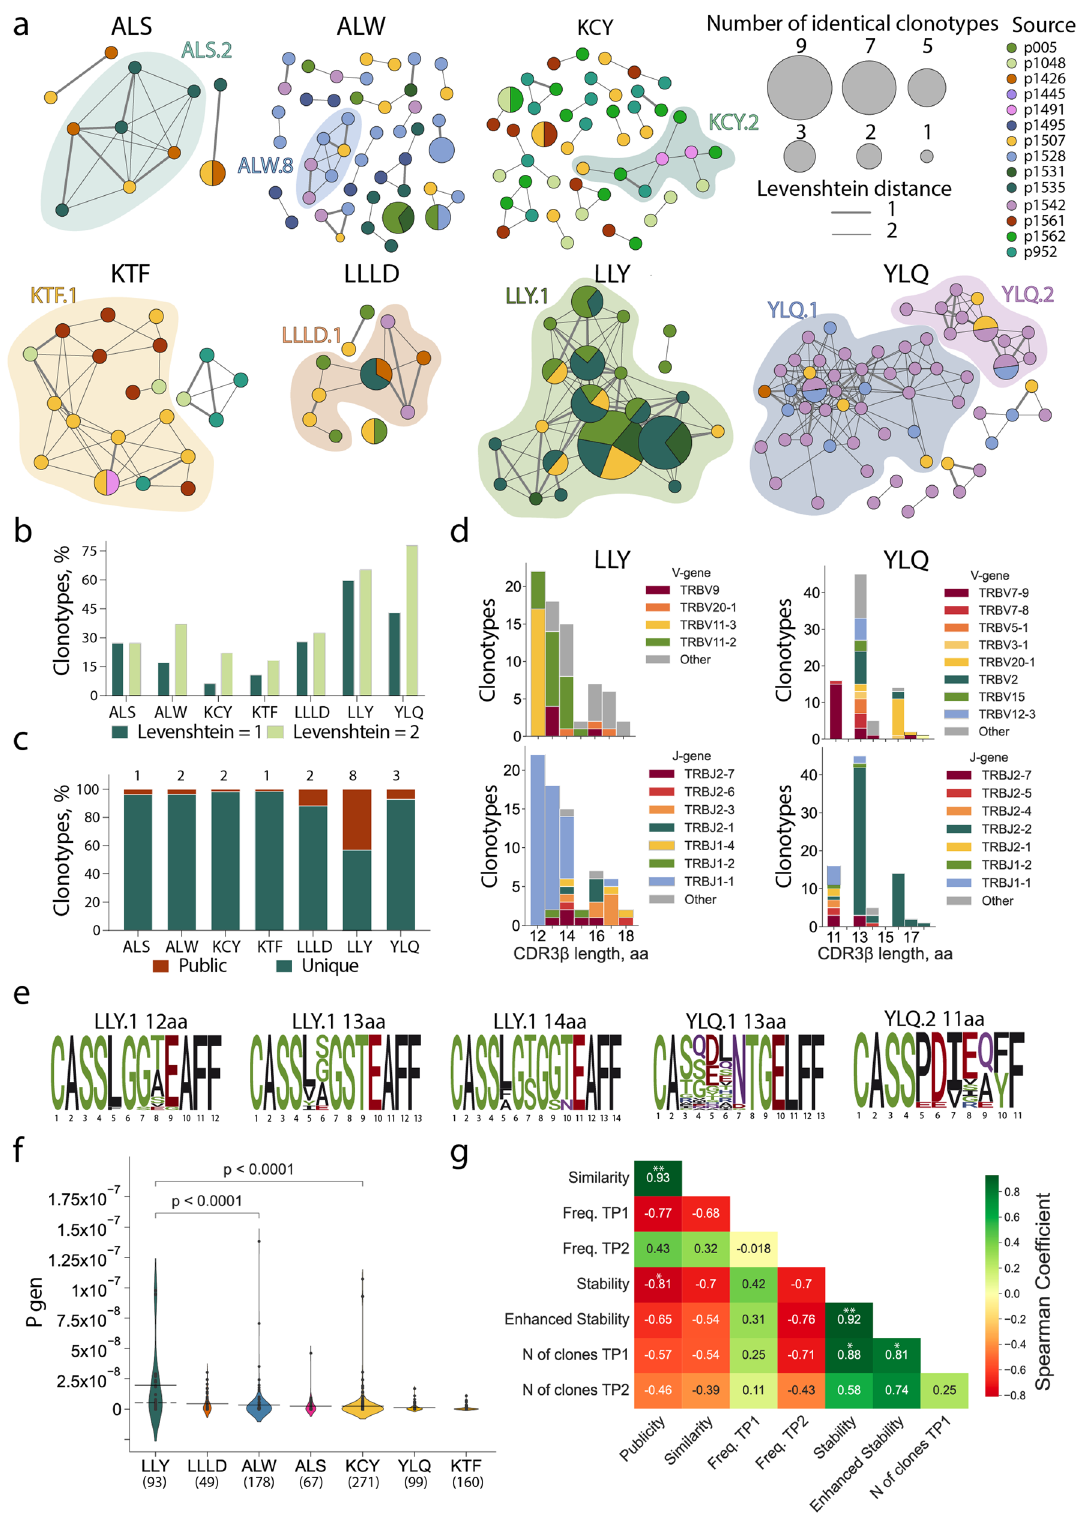
Next, we compared CDR3 β regions with speci fi city for LLY, YLQ, KTF, LLLD, and ALS epitopes with CDR3 β sequences annotated as recognizing the same epitopes in the Multiplex Both datasets contain CDR3 β sequences that are highly similar to the sequences obtained in this study (Supplementary Figure